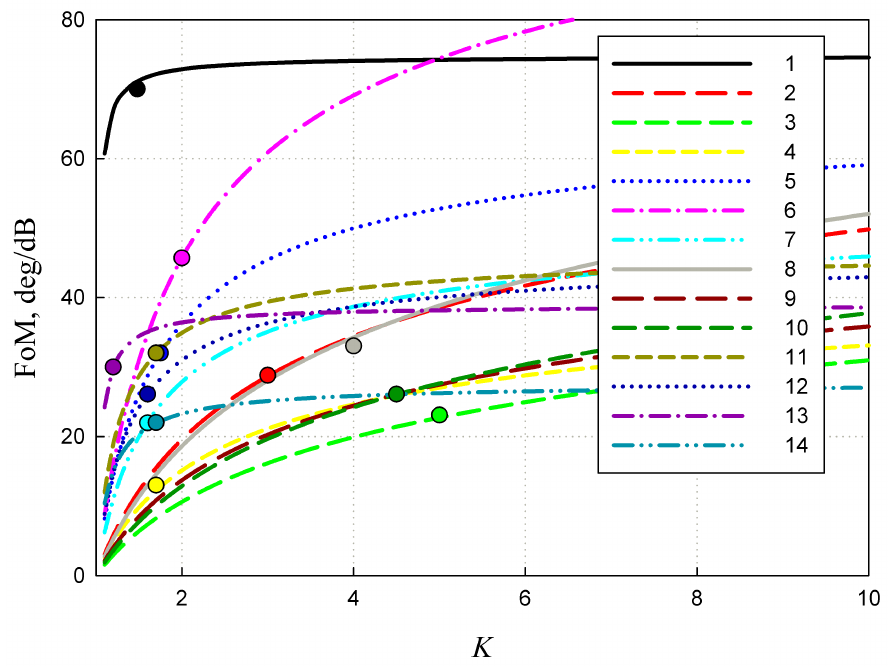
Figure 7. Figure of merit of phase-shifter versus tunability.